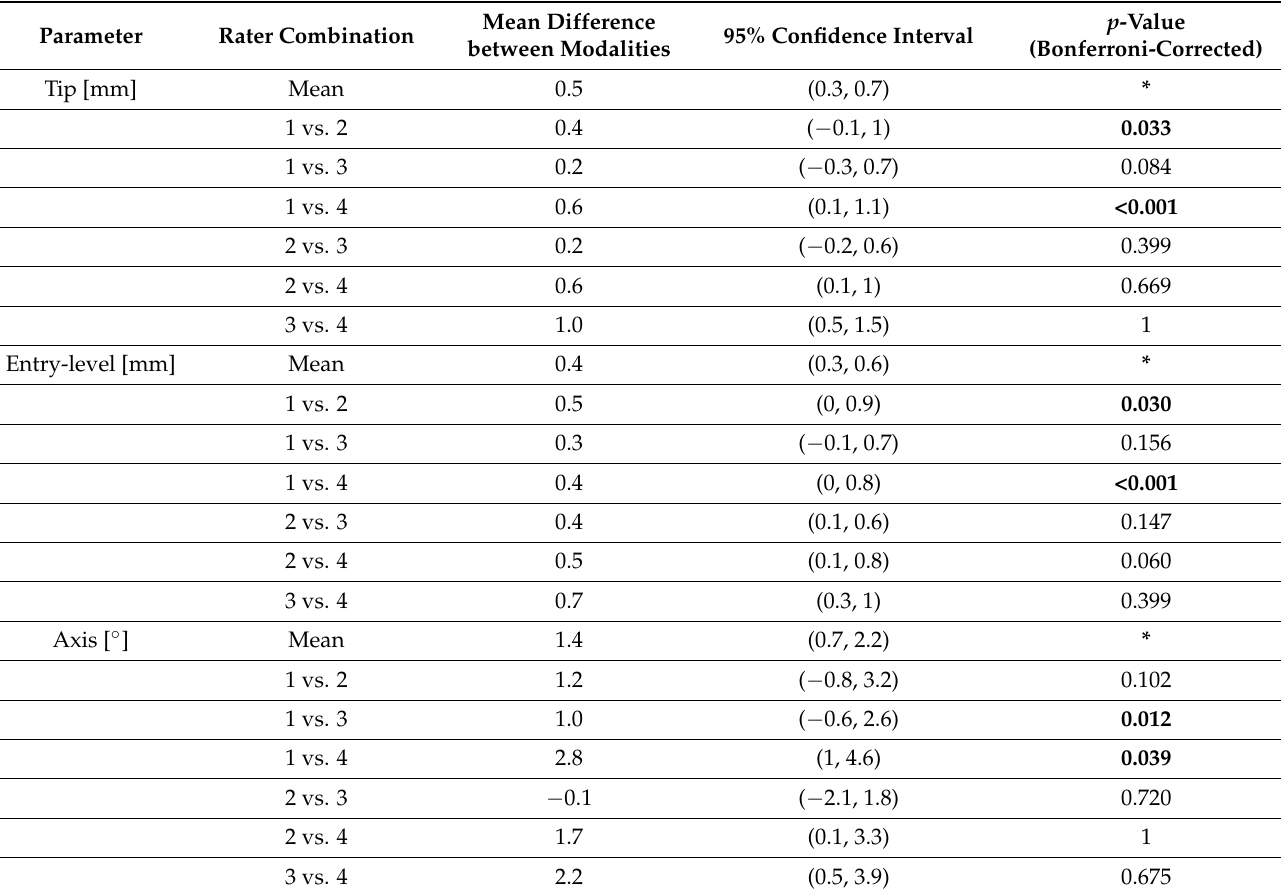
Table 2. Geometric deviations between the two imaging modalities (CBCT and MRI) were compared for all possible inter-rater combinations separately, for the implant tip, entry-level, and axis. Significant differences are marked in bold. * To avoid artificially increasing the study power, no statistical analysis of mean values was performed. Parameter